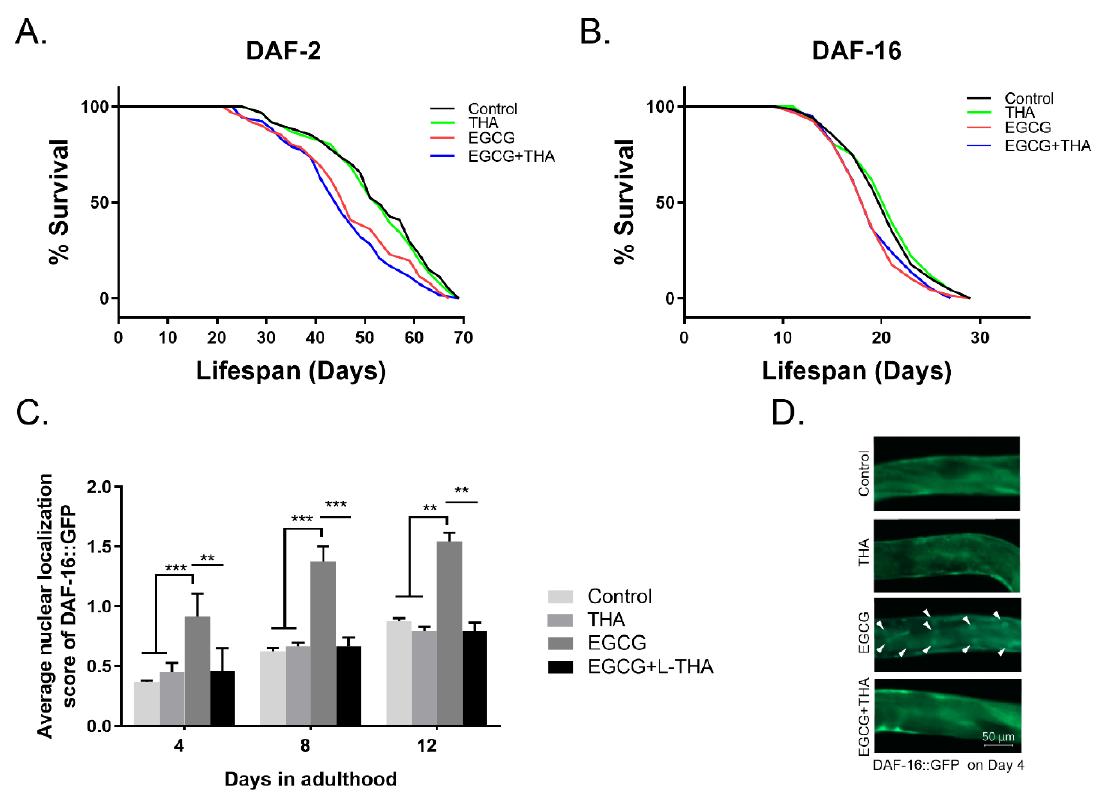
Figure 5. DAF-16 mediates theanine regulation of high-dose EGCG-induced lifespan shortening. ( A , B ) DAF-16 and DAF-2 mutant strains were treated with EGCG (1000 µ M) and theanine (200 µ M) starting from adulthood (day 0). Survival was recorded every two days, until all worms died ( n = 95–105 worms/treatment). ( C , D ) EGCG-induced nuclear accumulation of DAF-16::GFP in N2 worms treated with EGCG and theanine. Representative images and the quantitation result are shown; the localization of DAF-16::GFP from day 4 to day 12 was compared using the Fisher exact test. All error bars represent SEM, and differences were considered significant at ** p <0.01 and *** p < 0.001.